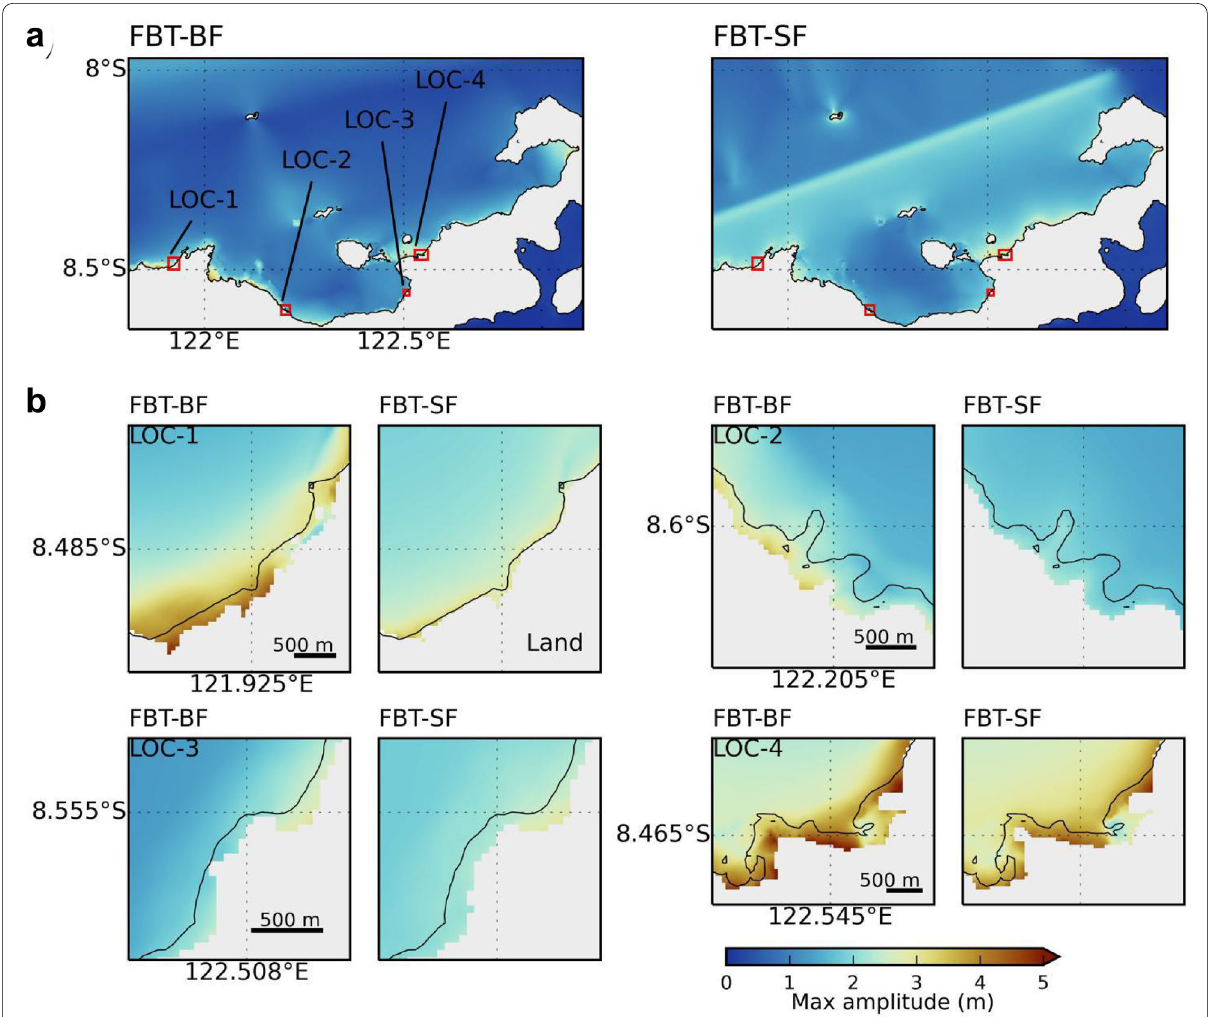
Fig. 5 Tsunami inundation result on the northern shore of Flores Island from the Flores back-arc thrust basal fault (FBT-BF) and splay fault (FBT-SF). a Maximum tsunami amplitude at the finest grid level; red boxes show locations of detailed inundation map shown in ( b